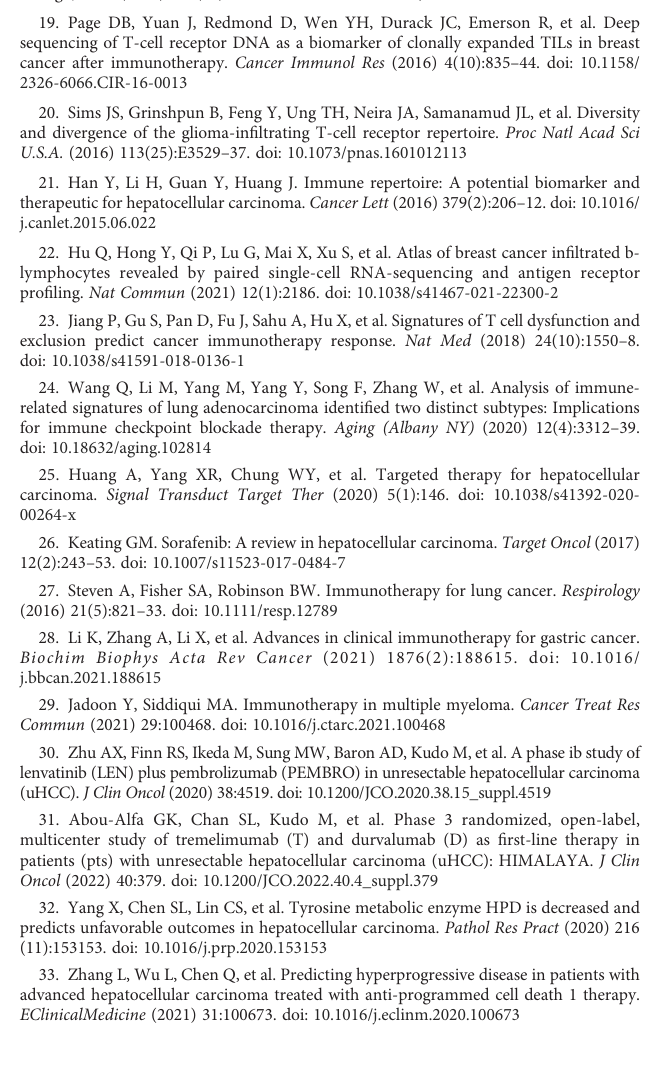
SUPPLEMENTARY FIGURE 3 Validation of prognostic signature in clinical subgroups. (A-F) The validity of the prognostic signature was validated in different clinical subgroups, including young (A) , old (B) , male (C) , female (D) , MVI negative (E) and MVI positive (F) . SUPPLEMENTARY FIGURE 4 The predictive ef fi cacy of prognostic signature was veri fi ed in different clinical subgroups. (A-D) Kaplan-Meier curves showed that in different clinical subgroups, such as low tumor grade (A) , high tumor grade (B) , early stage (C) and advanced stage (D) ,theoverallsurvivaltimeoflow-riskgroupwassigni fi cantlybetterthanthat of high-risk group. SUPPLEMENTARY FIGURE 5 Exploration of the molecular mechanisms behind the prognostic signature. genes highly expressed in the high-risk group. (C) Results of GO functional enrichment analysis of genes highly expressed in the low-risk group. (D)